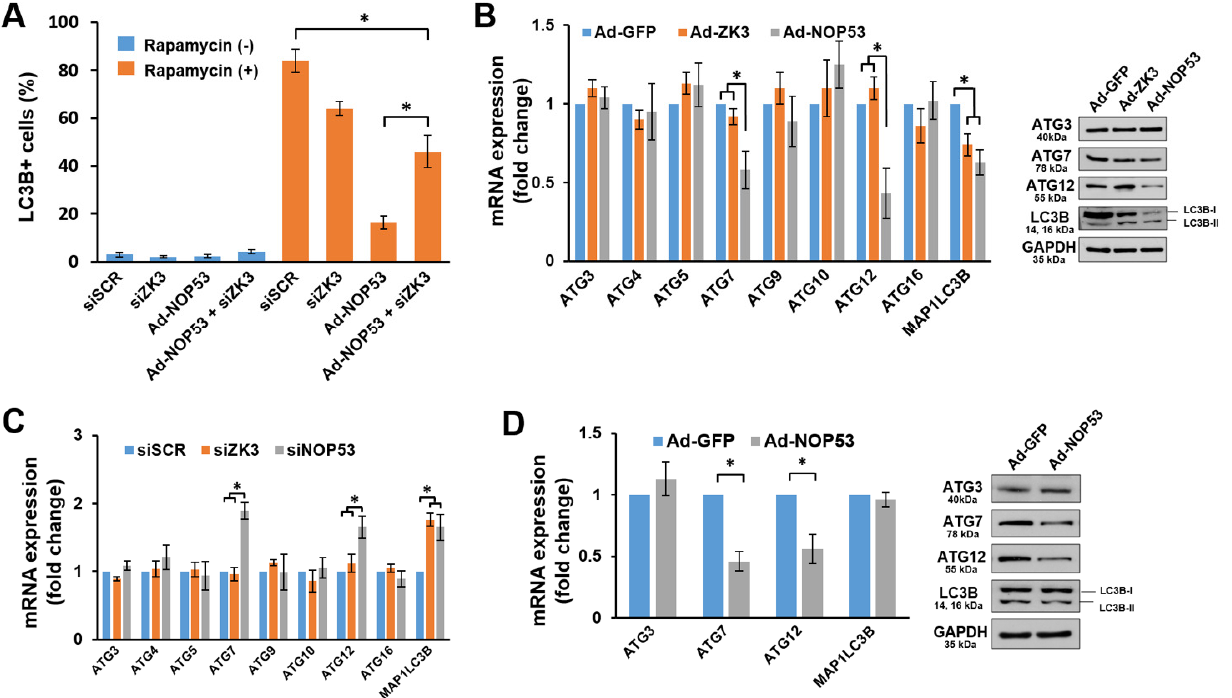
Figure 4. NOP53 regulates autophagy both through the ZKSCAN3 − dependent and − independent pathways. ( A ) NOP53 expression was upregulated in the control cells or ZKSCAN3 knockdown cells by transfecting siRNA targeted to ZKSCAN3 (siZK3) with or without the rapamycin treatment for 12 h. Then, the cells were immunocytochemically stained using an anti − LC3B antibody. The histogram shows the ratio of LC3B − positive cells. Data were obtained from three independent experiments and shown as the means ± SD; * p < 0.01. ( B ) Cells were transduced with adenovirus − expressing GFP (Ad − GFP), ZKSCAN3 (Ad − ZK3), or NOP53 (Ad − NOP53) for 24 h, and then, a qPCR (left panel) and Western blots (right panel) were carried out. The histogram data obtained from three independent experiments represent a fold increase in the mRNA level of each target gene relative to the basal level of the control cells. * p < 0.01. ( C ) mRNAs were extracted from siSCR, siZK3, and siNOP53 cells, and a qPCR was performed as in “B”. * p < 0.01. ( D ) Cells were transfected with siZK3 for 48 h, followed by an Ad − GFP or Ad − NOP53 infection for an additional 24 h, and a qPCR (left panel) was performed. The histogram data obtained from three independent experiments represent a fold increase in the mRNA level of each target gene relative to the basal level of the control cells. * p < 0.01. Representative immunoblot images are shown in the right panel.